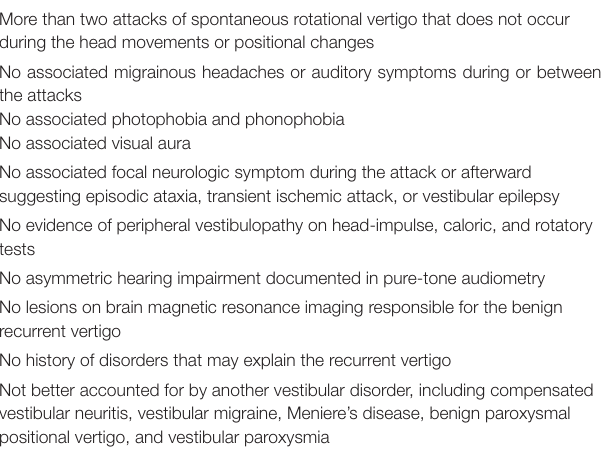
TABLE 1 | Inclusion criteria for pure benign recurrent vertigo.